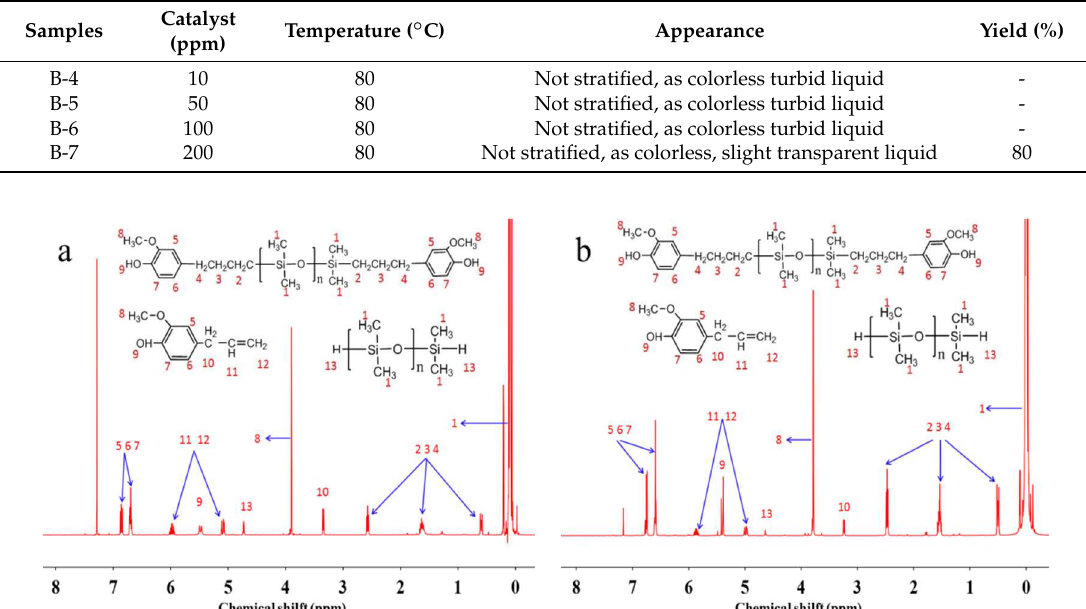
Table 4. Effect of catalyst concentration on activity of catalyst.